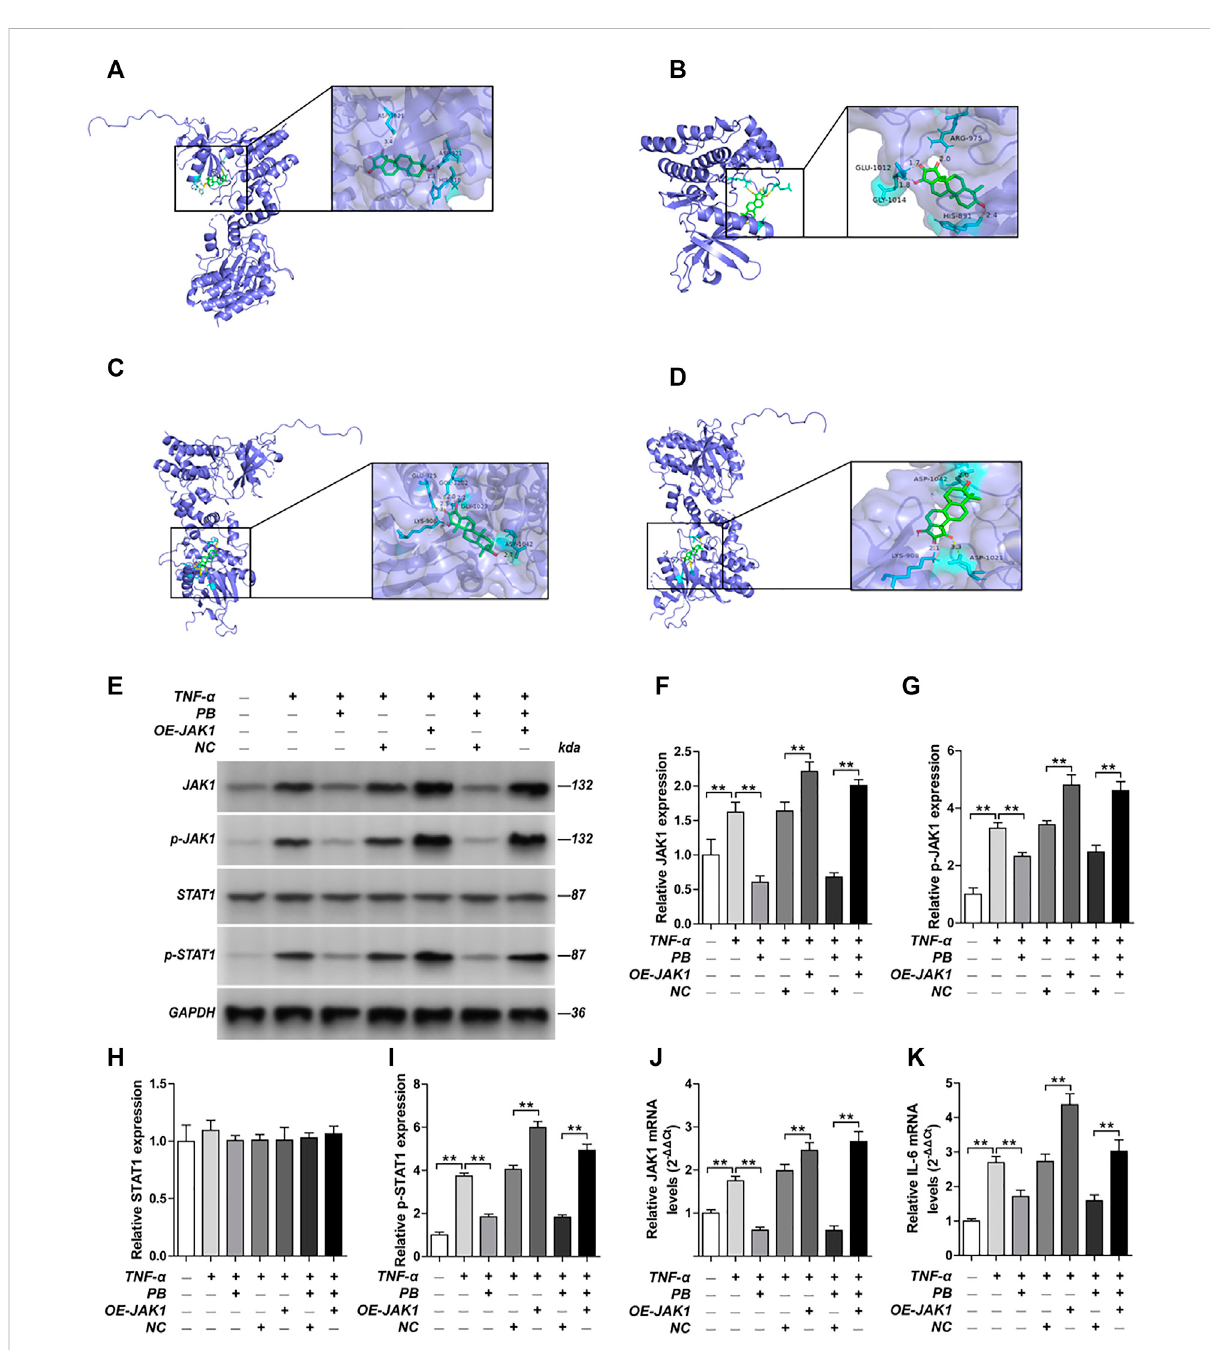
FIGURE 5 Molecular models of Palbinone (PB) binding to its predicted protein targets and the anti-in fl ammatory effect of PB by inhibiting JAK1 in HISF cells. (A) JAK1bindingPB; (B) JAK2bindingPB; (C) PBbindingtoJAK1inATPbindingsitesLYS908; (D) PBbindingtoJAK1inATPbindingsitesLYS908. HISF cells were transfected with NC, OE-JAK1 by lentiviral vector. After HISF cells were treated with TNF- α (20 ng/ml) for 24 h, they were incubated with PB(10 μ g/ml)for 6 h.The expressionof JAK1 (E,F) ,p-JAK1 (E,G) , STAT1 (E,H) and p-STAT1 (E,I) fromtheindicatedgroup weredetected by Western blot assay. The mRNA levels of JAK1 (J) and IL-6 (K) from the indicated group were detected by qPCR. Results were mean ± SD for three individual experiments. * p < 0.05, ** p <